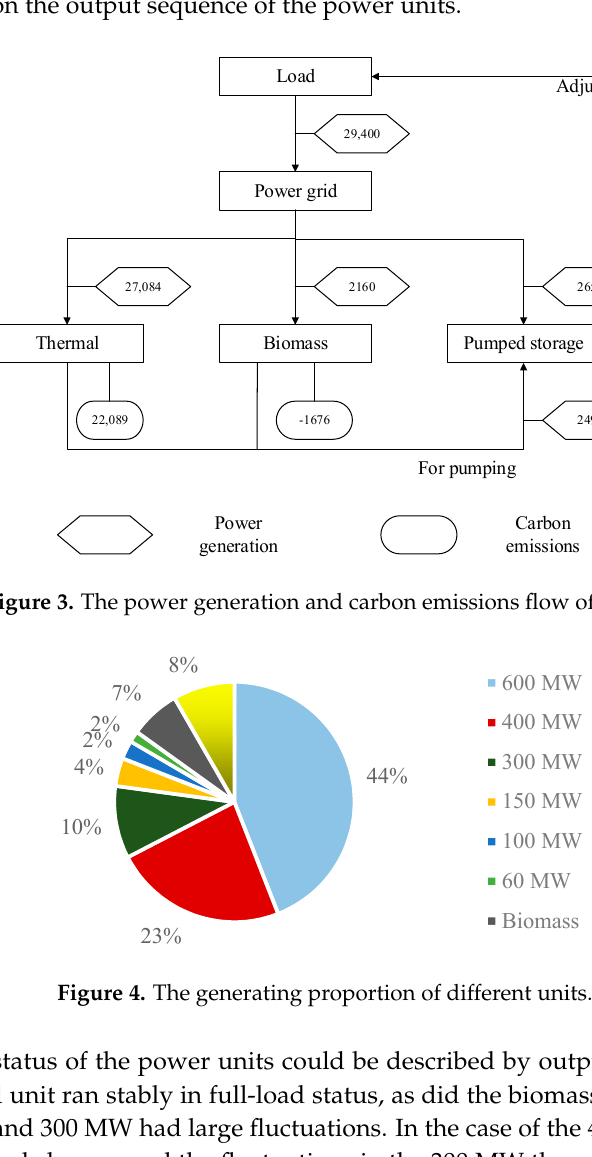
Figure 5. Power curves of different units. 4.1.2. Dispatching Thermal Units Only Figure 6 shows the thermal power units’ dispatching results when only the thermal power units are operated in the power generation system. The inner ring is the thermal power output structure of the thermal units only, and the outer ring is the result of the basic system. Based on this comparison, it is obvious that in the case of thermal power units only, with the exception of the 400 MW and 300 MW units, the generating output of the other units was smaller than that of the basic system, which indicated that the share of the generating units of the two units was taken up by the other units in the basic system. Figure 6. The comparative results between thermal-only units and the basic system. Compared to thermal-only power system, the basic system was friendlier to the environment. From Table 5, the total power generation was 29,400 MW·h in the case of thermal power units only, which